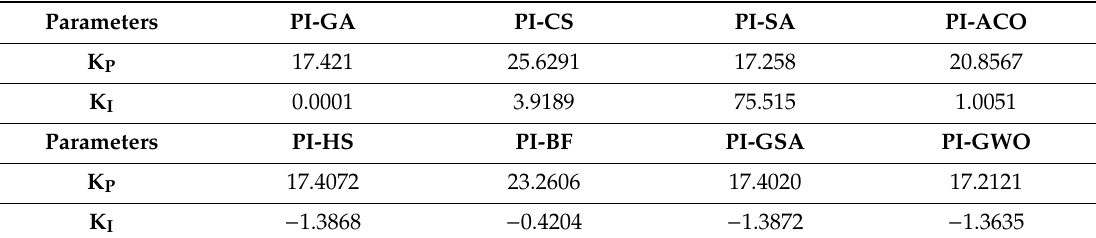
Table 3. PI tuning parameters using di ff erent optimization for the DC